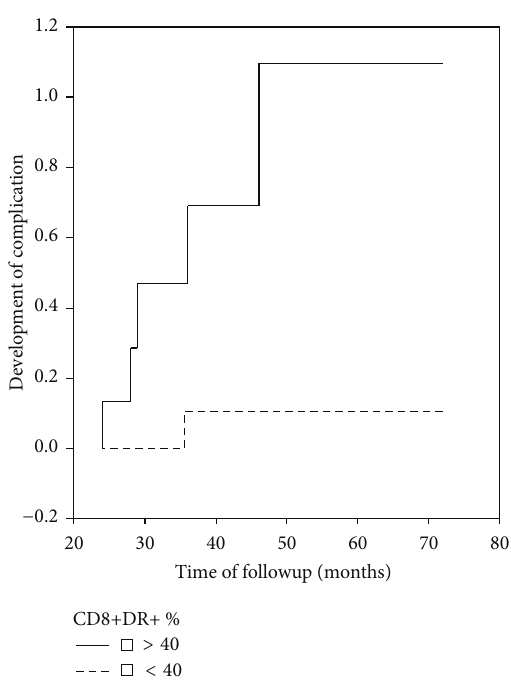
Figure 2: Kaplan Meier curves for development of clinical compli- cations in thrombotic APS patients according to baseline CD8+DR+ percentages. Log Rank 5.43, 𝑃 = 0.019